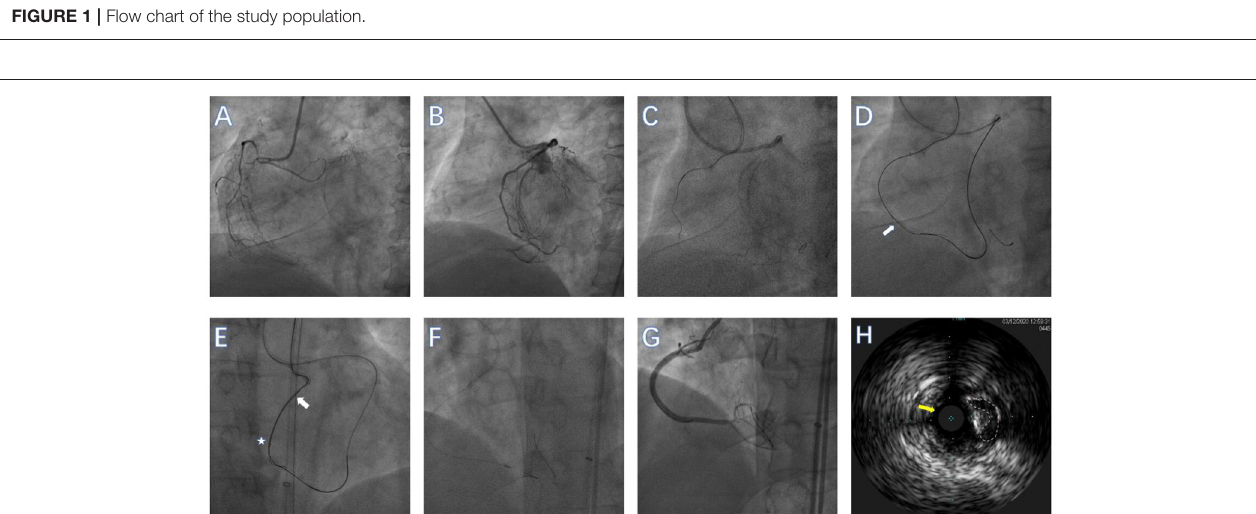
FIGURE 2 | Performing Guidezilla TM reverse controlled antegrade and retrograde subintimal tracking (CART) during rotational atherectomy (RA) in a right coronary artery (RCA) CTO lesion. (A) RCA in left anterior oblique view showing an ambiguous proximal cap without obvious calcification. (B) RCA in left anterior oblique view showing the distal cap of the RCA. (C) Antegrade wire in the subadventitial space of mid-RCA. (D) The CTO lesion was crossed over using the Guidezilla TM reverse CART technique (the white arrow represents the dilated balloon). (E) Retrograde wire (white arrow) was advanced into the Guidezilla TM (white star) of the RCA and externalized. (F) Rotational atherectomy was then performed using a 1.25-mm burr. (G) Angiography after successful CTO-PCI. (H) Intravascular ultrasound confirmed that the guidewire (yellow arrow) was in the subadventitial space (The white dotted line represents the true lumen of the